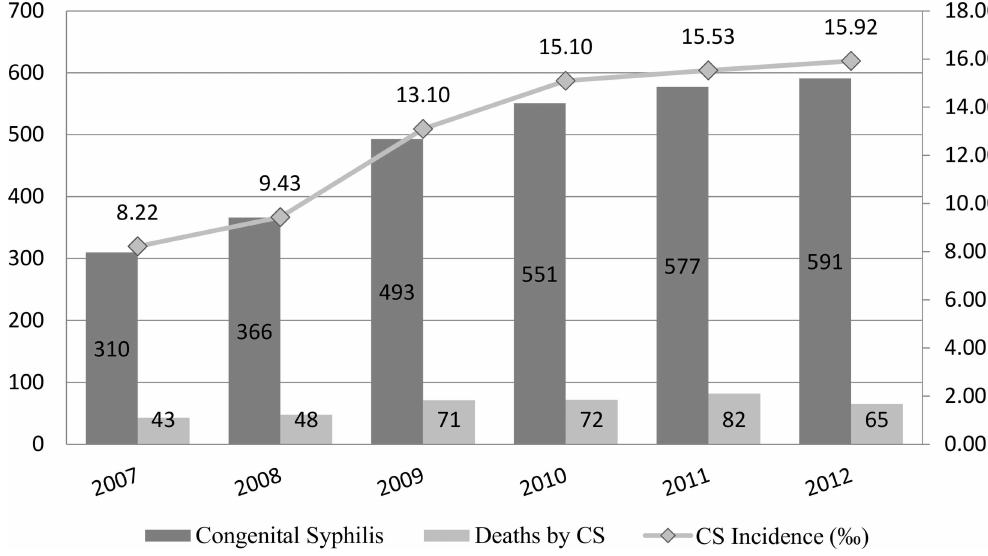
Fig 2. Congenital Syphilis Incidence Rates per 1000 Live births and Congenital Syphilis, by Year of Notification, Fortaleza-Ceara´, 2007–2012. Source: Secretariade Sau´de de Fortaleza, Sistema Nacionalde Agravos de Notificac¸ ã o (Sinan).